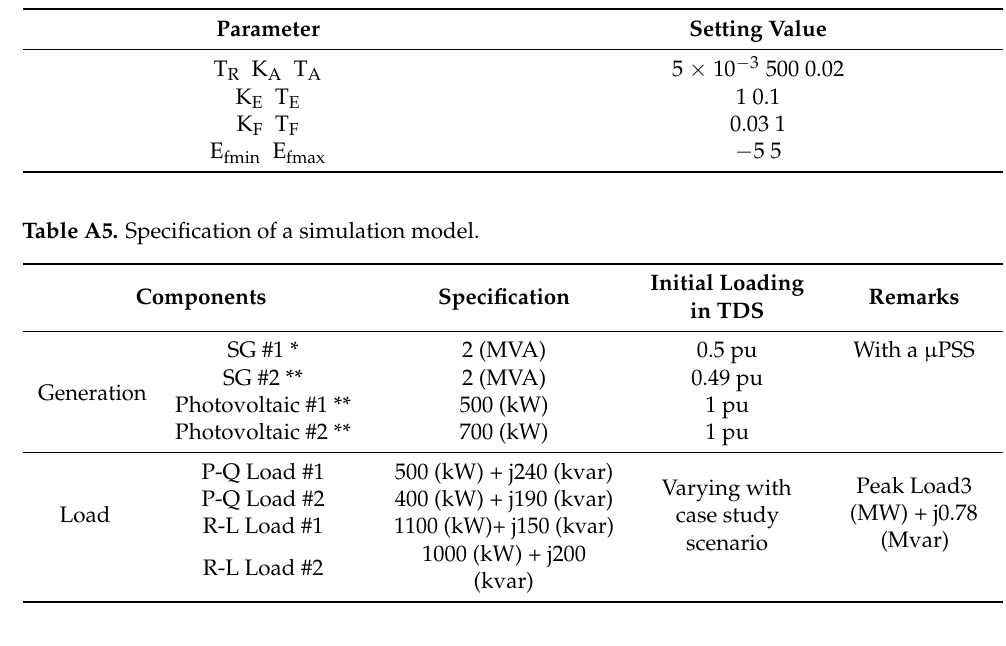
Table A4. Excitation system.